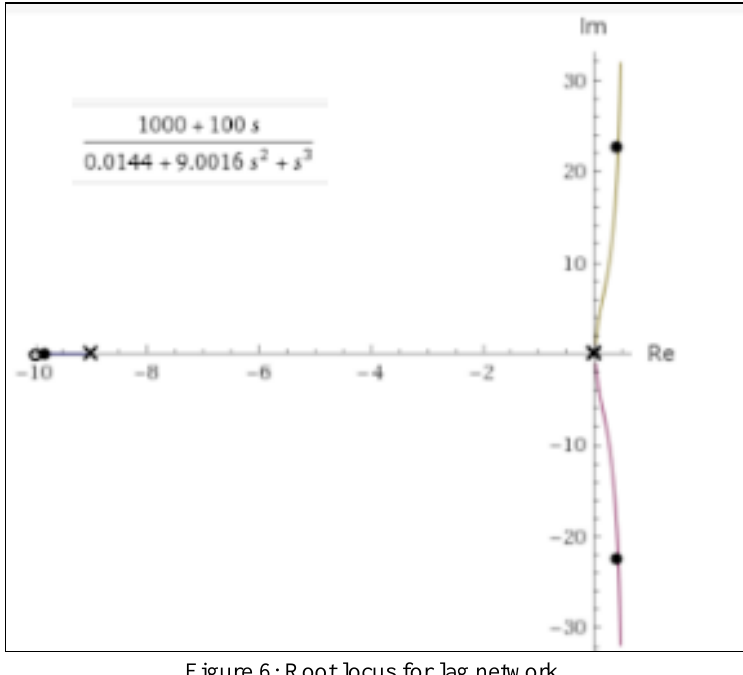
Figure 6: Root locus for lag network.